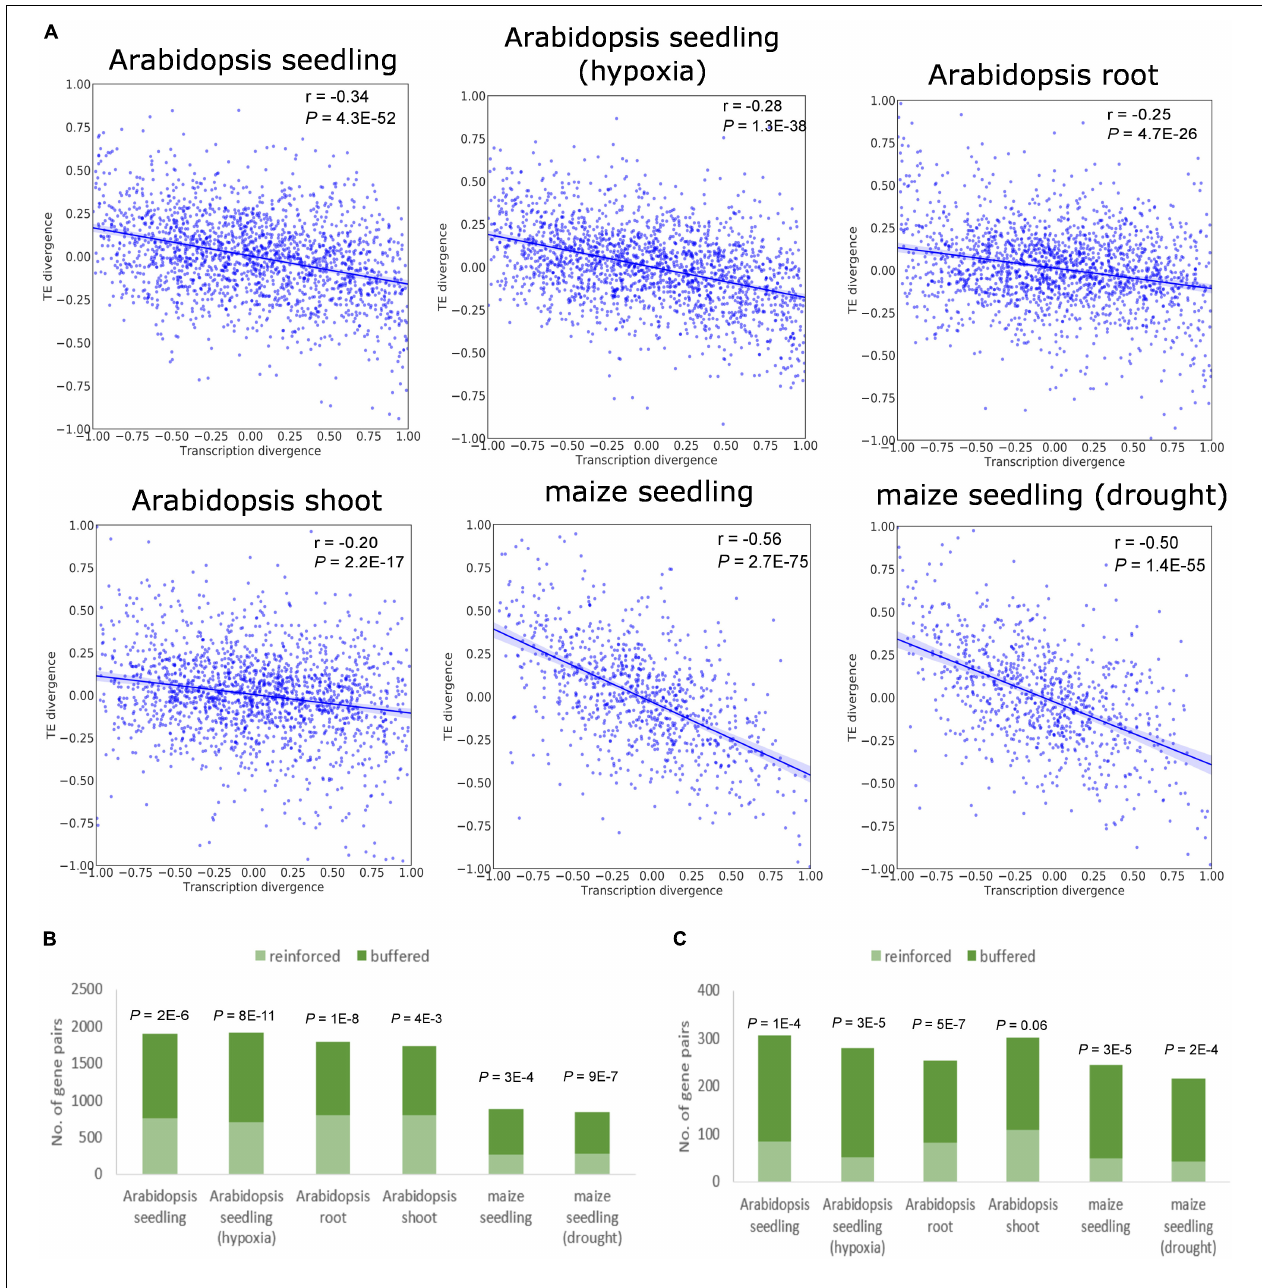
FIGURE 1 | Relationship between mRNA abundance divergence and TE divergence for WGD duplicates. (A) Scatter plots showing the correlation between the relative divergence in mRNA abundance and the relative divergence in TE. The Pearson’s correlation coefficient and P -value are indicated. The shaded areas represent 95% confidence interval in both plots. (B,C) Numbers of gene pairs whose transcriptional divergence decreases (referred to as “buffered”) or increases (referred to as “reinforced”) at the translational level for all WGD duplicates (B) and those with TE fold difference ≥ 2 (C) . P -values derived from the binomial test are shown above the